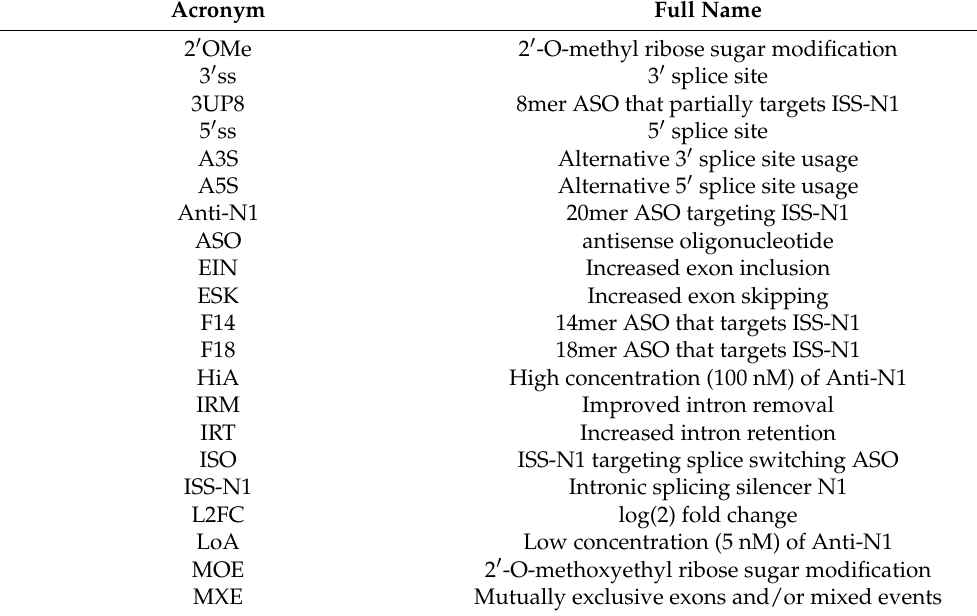
Table 1. Acronyms used in this